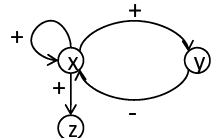
Figure 6: The network of mucus production in P. aeruginosa , where x positively regulates mucus production, represented as z , and y inhibits x , which x positively